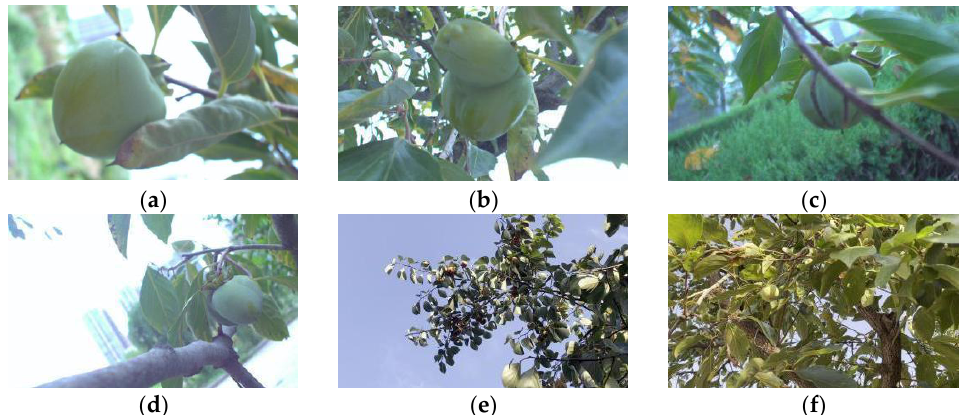
Figure 3. Actual persimmon images in a complex environment: ( a ) single fruit; ( b ) overlapping Figure 2. Actual persimmon images in a complex environment: ( a ) single fruit ; ( b ) overlapping fruit; ( c ) occlusion; ( d ) no occlusion; ( e ) long-distance shooting; and ( f ) close-range shooting.